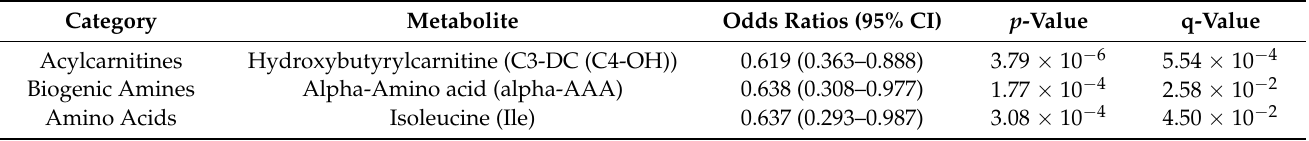
Table 4. Metabolites significantly associated with T2D in the logistic regression full model. The dependent variable was T2D status, whereas the independent variables were the log transformed and standardized concentration of each metabolite, adjusted for age, sex, BMI, smoking status, physical activities, HDL-C, blood pressure, triglycerides, and fasting glucose. q-values were reported as p -values adjusted for multiple testing by Bonferroni correction. Only metabolites with p -value lower than 0.00034 (0.05/146) were included in this table.